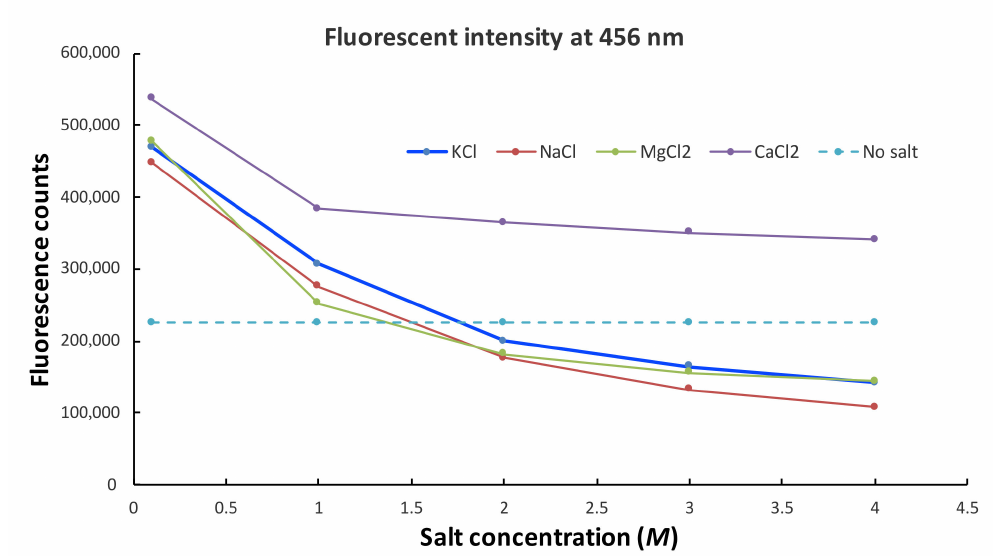
Figure 4. Salt-dependent fluorescence of 4-phenyl-1,8-naphthalimide. The dye solutions were all prepared at 1 µ M.